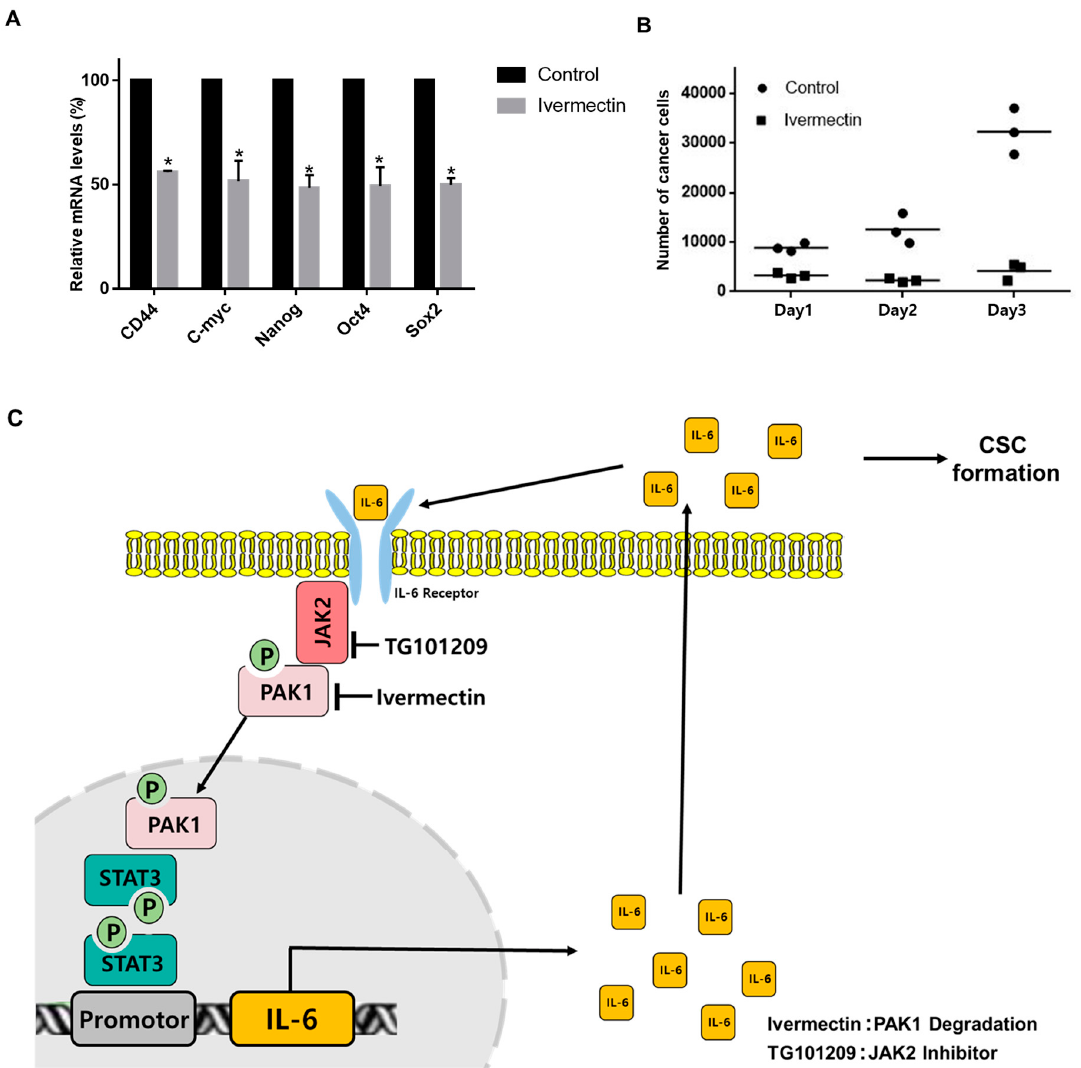
Figure 8. The e ff ects of ivermectin, a PAK1 inactivator, on CSC loads in breast cancer. ( A ) Transcriptional Figure 8. The effects of ivermectin, a PAK1 inactivator, on CSC loads in breast cancer. ( A ) levelsofSox2, Oct4, CD44, c-Myc, andNanoggeneswereanalyzedinivermectin-treatedmammospheres Transcriptional levels of Sox2, Oct4, CD44, c-Myc, and Nanog genes were analyzed in ivermectin- using specific primers. β -actin was used as a control. ( B ) E ff ect of ivermectin on mammosphere growth. treated mammospheres using specific primers. β -actin was used as a control. ( B ) Effect of ivermectin Ivermectin treatment prevents mammosphere proliferation. Ivermectin-treated mammospheres were on mammosphere growth. Ivermectin treatment prevents mammosphere proliferation. Ivermectin- treated mammospheres were dissociated into single cells and plated in 6-well plates in equal plating, the cells were counted. Two and 3 days later, the cells were counted. The data are presented numbers. Twenty-four hours after plating, the cells were counted. Two and 3 days later, the cells were as the mean ± SD; n = 3; * p < 0.05 vs. control. ( C ) The proposed model for CSC formation by counted. The data are presented as the mean ± SD; n = 3; * p < 0.05 vs. control. ( C ) The proposed model PAK1 inactivator (ivermectin) treatment blocks the Stat3 signaling pathway and IL-6 gene